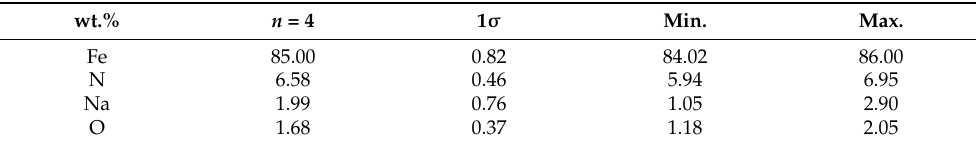
Table 5. Average elemental composition of Na-bearing siderazot grains from electron microprobe analysis averaged over 4 spots.